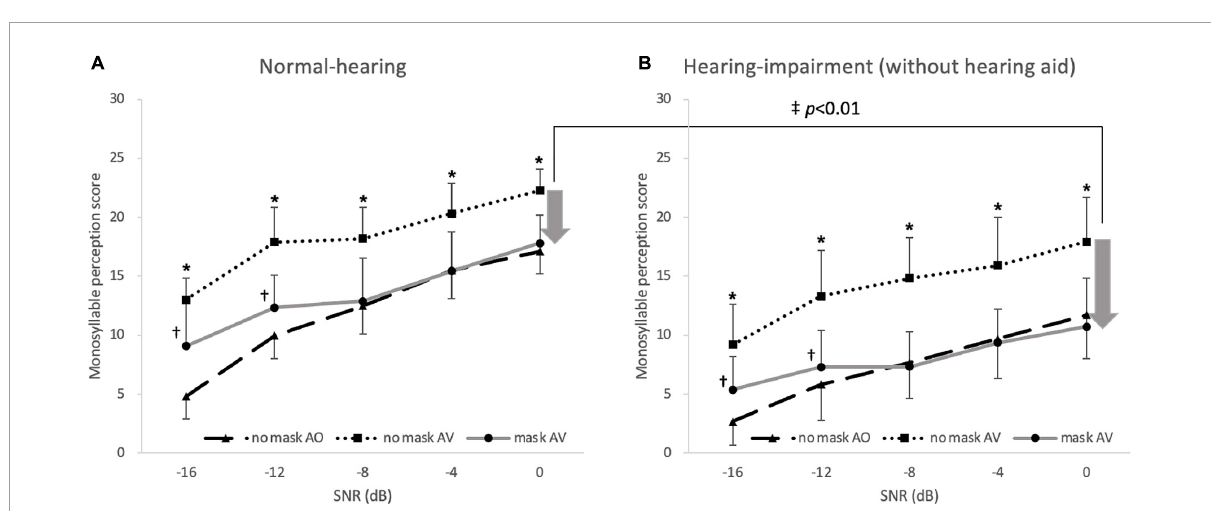
FIGURE3 Monosyllabic speech perception in noise under no-mask–auditory–verbal (AV; filled squares), mask–AV; filled circles, and no-mask–auditory only (AO; filled triangles) conditions. In the (A) normal-hearing and (B) hearing-impaired groups, the speech perception score was lower